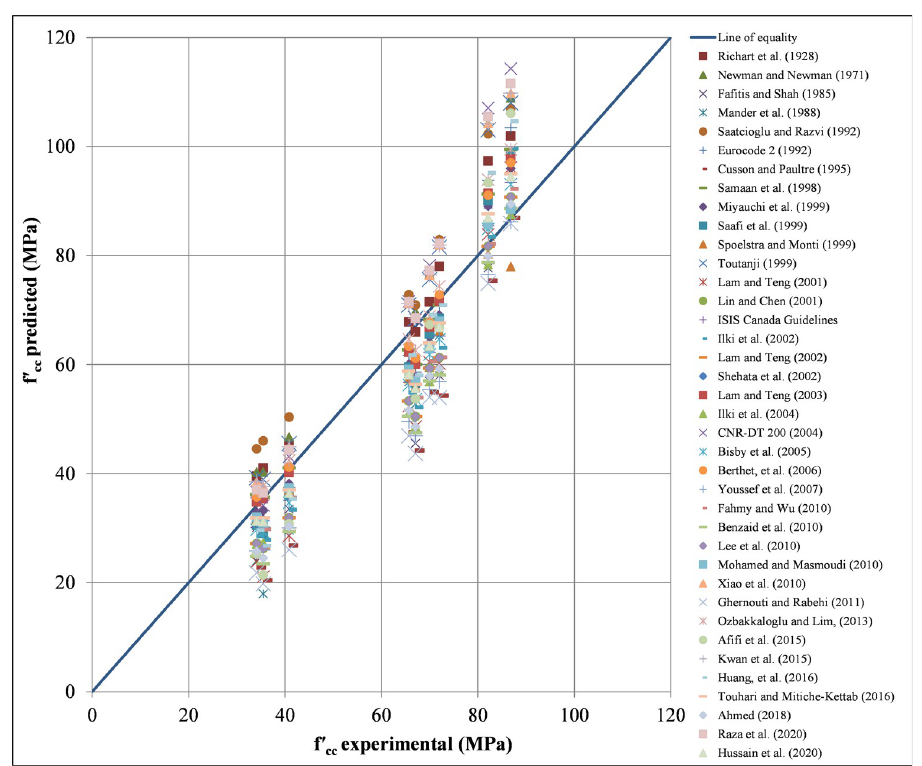
Fig 9. Experimental results vs. predicted values for maximum stress in confined